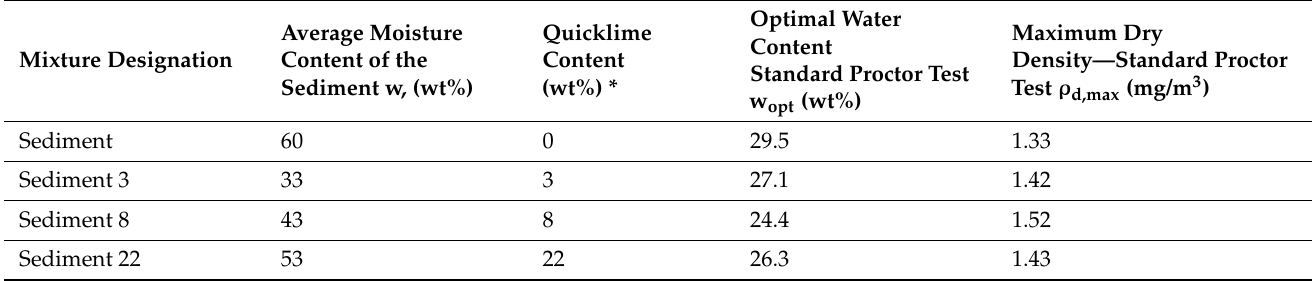
Table 6. Composition of the optimal sediment/quicklime mixtures and their installation